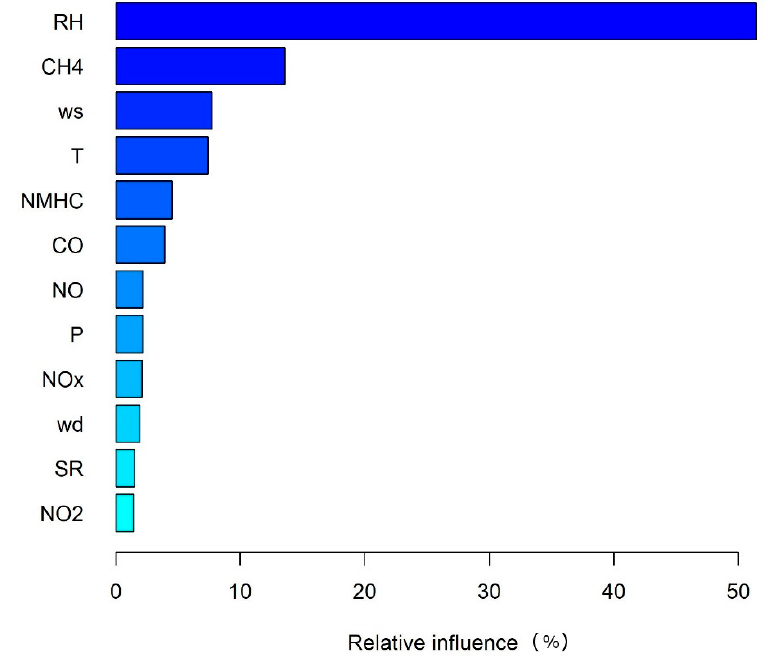
Figure 3. Relative influence of the input variables.